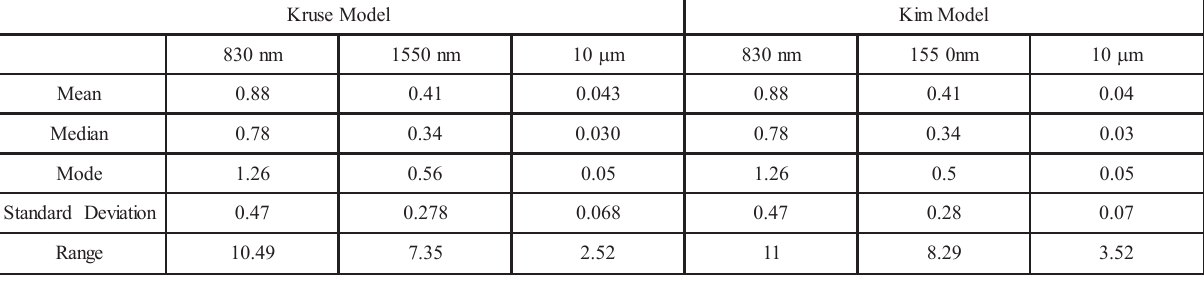
TABLE 2. DESCRIPTIVE STATISTICS OF ESTIMATED OPTICAL ATTENUATION FOR